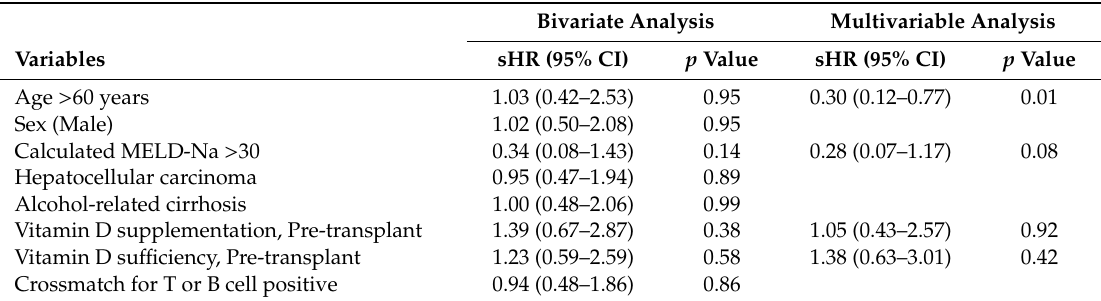
Table 5. Fine and Gray proportional subdistribution hazard model for ACR development in No Supplement and Pre group.